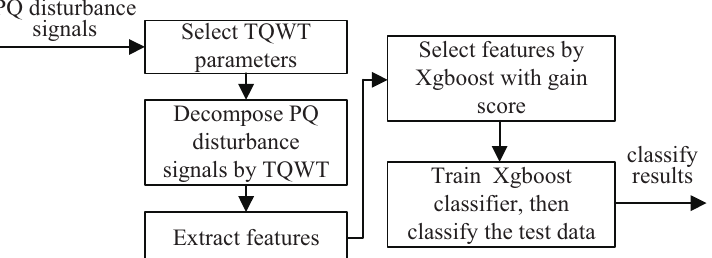
Figure 1. The proposed method framework.